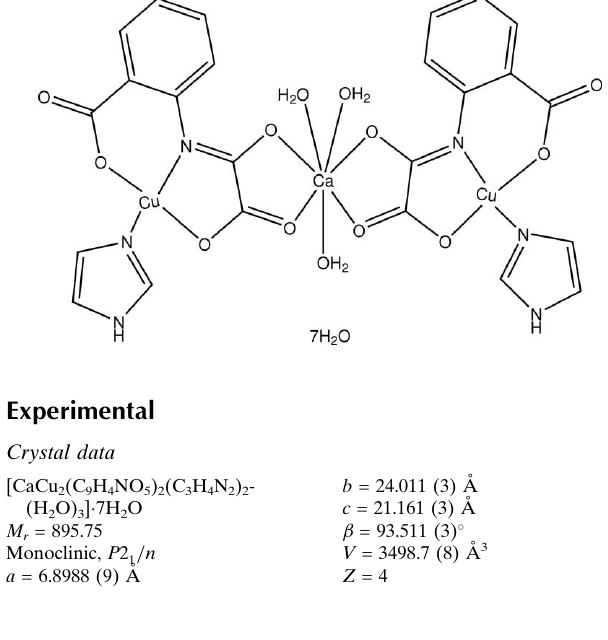
In the title heterotrinuclear coordination compound, [CaCu pentagonal–bipyramidal geometry and bridges two (1 H - imidazole)[2-(oxaloamino)benzoato(3 (cid:1) )]copper(II) units in its equatorial plane. Each Cu II atom has a normal square- planar geometry. The molecule has approximate local (non- crystallographic) mirror symmetry and 23 classical hydrogen bonds are found in the crystal structure.